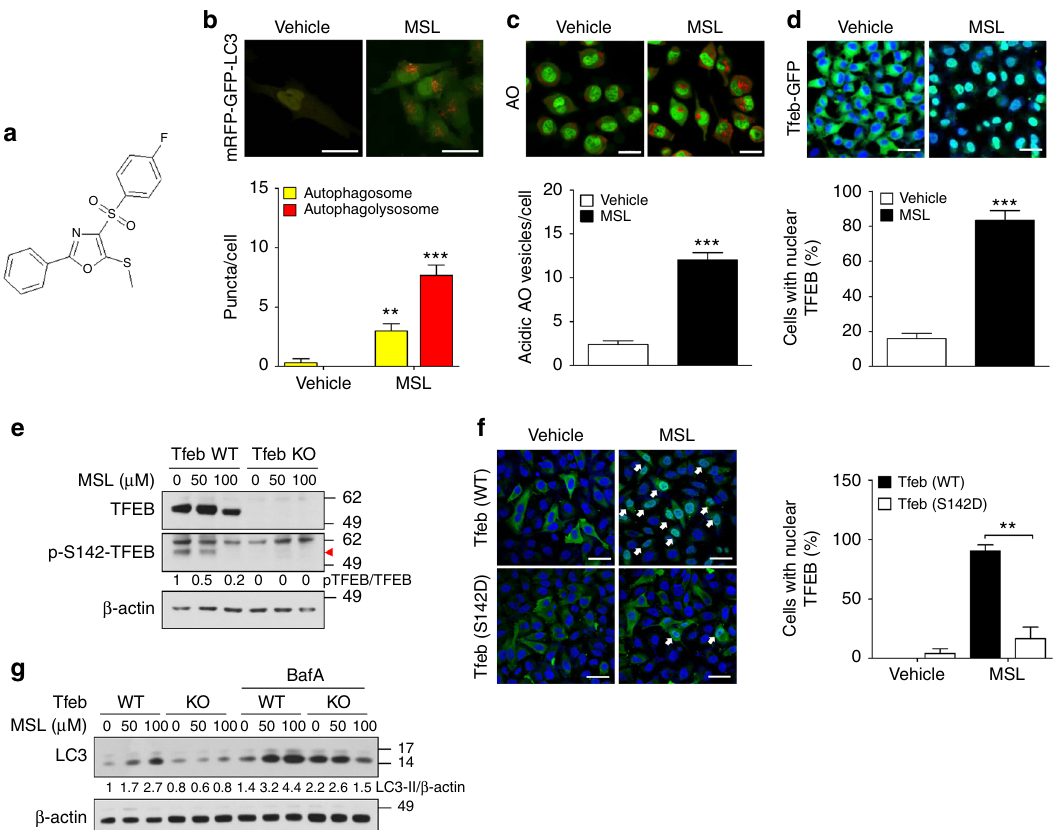
Fig. 1 Identi fi cation of an autophagy enhancer small-molecule (MSL) inducing nuclear translocation of TFEB. a Chemical structure of autophagy enhancer, MSL [4-(4- fl uorophenyl)sulfonyl-5-methylthio-2-phenyloxazole]. b HeLa cells transfected with mRFP-GFP-LC3 were treated with MSL, and confocal microscopy was performed. Red puncta represents autophagolysosome (upper). The numbers of yellow and red punctae representing autophagosomes and autophagolysosomes, respectively, were counted ( t = 4.9, df = 6 for autophagosome; t = 10.3, df = 6 for autophagolysosome) (lower). c MSL-treated cells were stained with AO, and confocal microscopy was performed (upper). The number of acidic AO vesicles was counted ( t = 10.3, df = 4) (lower). d Tfeb-GFP -transfectants were treated with MSL, and then subjected to confocal microscopy to examine nuclear translocation of TFEB (upper). The number of cells with nuclear TFEB was counted ( t = 10.9, df = 4) (lower). e WT and Tfeb knockout HeLa cells were treated with MSL, and cell extract was subjected to Western blot analysis using the indicated antibodies. Red arrow indicates phospho-S142-TFEB band. Numbers below phospho-S142-TFEB immunoblot bands indicate fold changes normalized to total TFEB bands. f HeLa cells transfected with 3x FLAG - Tfeb (WT) or - Tfeb (S142D) mutant were treated with MSL. Confocal microscopy was conducted after immunostaining with anti-FLAG antibody. Arrows indicate cells with nuclear translocation of TFEB (left panel). The number of cells with nuclear TFEB among FLAG + cells was counted ( F = 51.7, df treatment = 3, df residual = 6) (right). g WT and Tfeb knockout HeLa cells were treated with MSL in the presence or absence of ba fi lomycin A1 (BafA), and cell extract was subjected to Western blot analysis using the indicated antibodies. Numbers below LC3 immunoblot bands indicate fold changes of LC3-II normalized to β -actin bands. All data in this fi gure are the means ± s.e.m. from ≥ 3 independent experiments performed in triplicate (scale bar, 20 μ m). ** P < 0.01 and *** P < 0.001 by one-way ANOVA with Tukey ’ s post-hoc test ( f ) and two-tailed Student ’ s t -test ( b – d transfection of constitutively active calcineurin mutant ( HA - Δ CnA ) together with regulatory calcineurin B subunit ( CnB ) 24